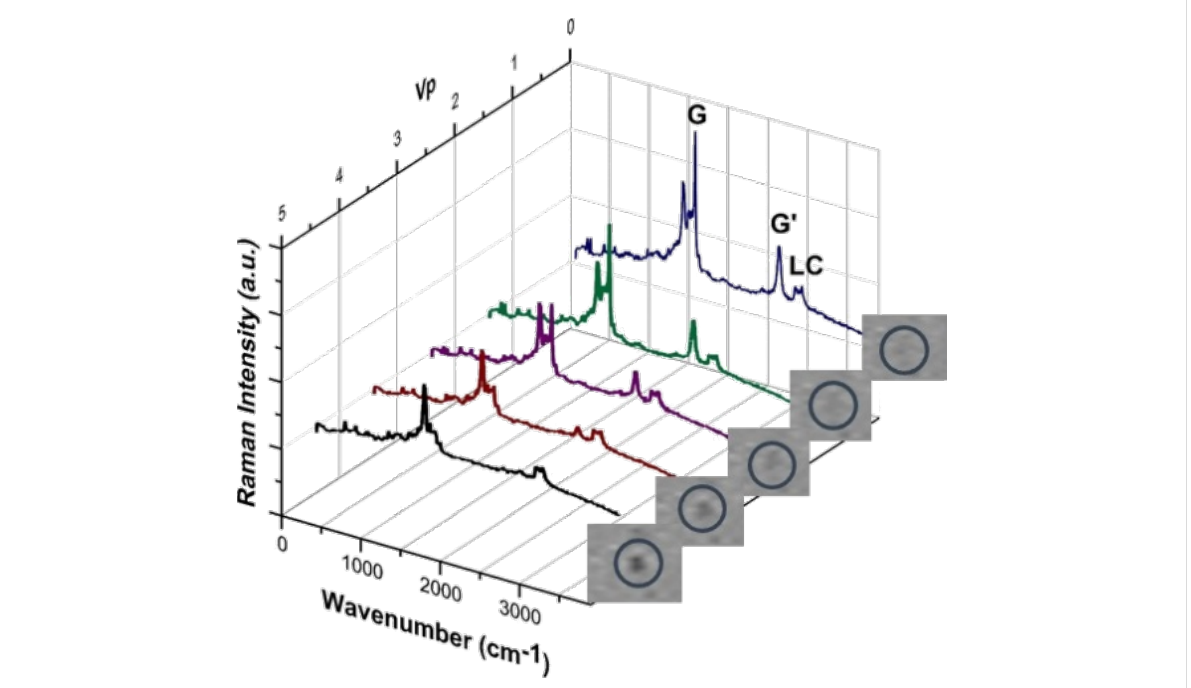
Figure 4: Raman spectrum at different driving voltages (0 V, 1.5 V, 2.5 V, 3.5 V and 4.5 V). The microscope images confirm the light scattering differ- ence between un-switched (0 V) and switched state (5.5· V p ).